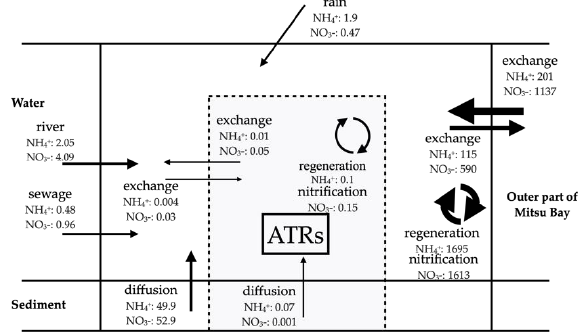
Figure 7. Annual average nitrogen flows (kg N day −1 ) from various sources in the ATR areas (V: 3200 m −3 ) and in Mitsu Bay (V: 144,000,000 m −3 ). Arrow size reflects their contributions, where thicker arrows indicate major pathways (Thick arrow: > 10 kg P day − 1 , moderate arrow: 0.1–10 kg P day − 1 . thin arrow: 0–0.1 kg P day − 1 ). The dotted square indicates the imaginary demarcation between the ATR areas and Mitsu